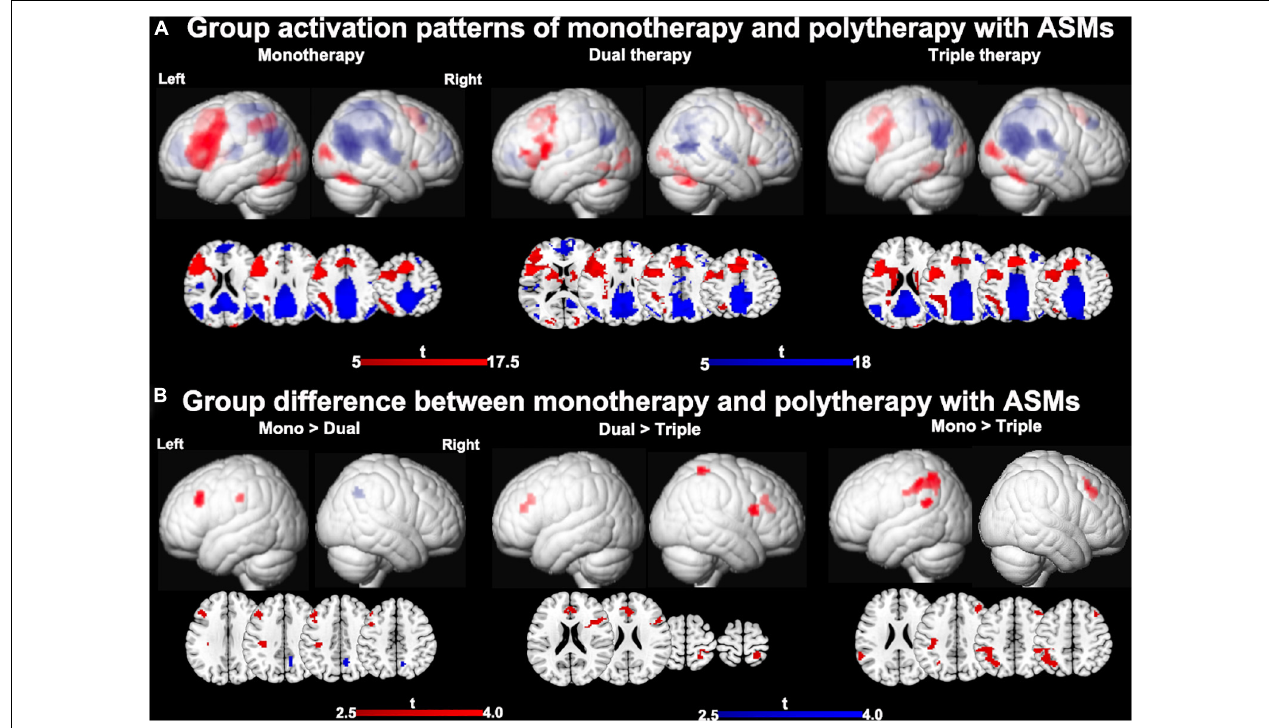
FIGURE 2 | Main effects of number of ASMs with moderate cognitive side effects on cognitive activation patterns. (A) One-sample t- tests of functional magnetic resonance imaging activation and deactivation maps for the three different therapy groups are demonstrated on a surface-rendered brain template and subcortical changes are demonstrated superimposed on MNI 152 template with a bar chart indicating t score. Task-relevant activations (red) include bilateral inferior and middle frontal gyrus (left > right), bilateral supplementary motor area, the left dorsolateral parietal region, and bilateral inferior occipital lobes. Areas of task-related deactivations (blue) include the bilateral precuneus, posterior cingulate, angular gyrus, and medial prefrontal and lateral temporal cortex. P < 0.05, FWE-corrected. (B) Significant group differences between monotherapy and polytherapy are demonstrated on a surface-rendered brain template and subcortical changes are demonstrated superimposed on MNI 152 template with a bar chart indicating t score. People on monotherapy show greater activation in frontal cognitive networks and deactivation in task-negative networks than people with 2 ASMs. People on monotherapy or on two ASMs show greater frontal and parietal activations than people on 3 ASMs. P < 0.005 uncorrected, extent threshold 20 voxels. ASM, anti-seizure